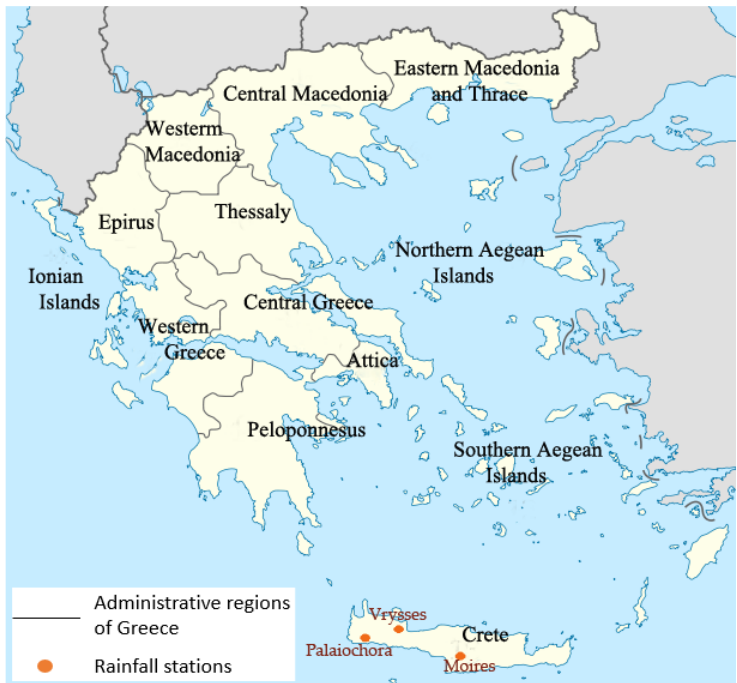
Figure 2. Rainfall stations studied on Crete Island, Greece.